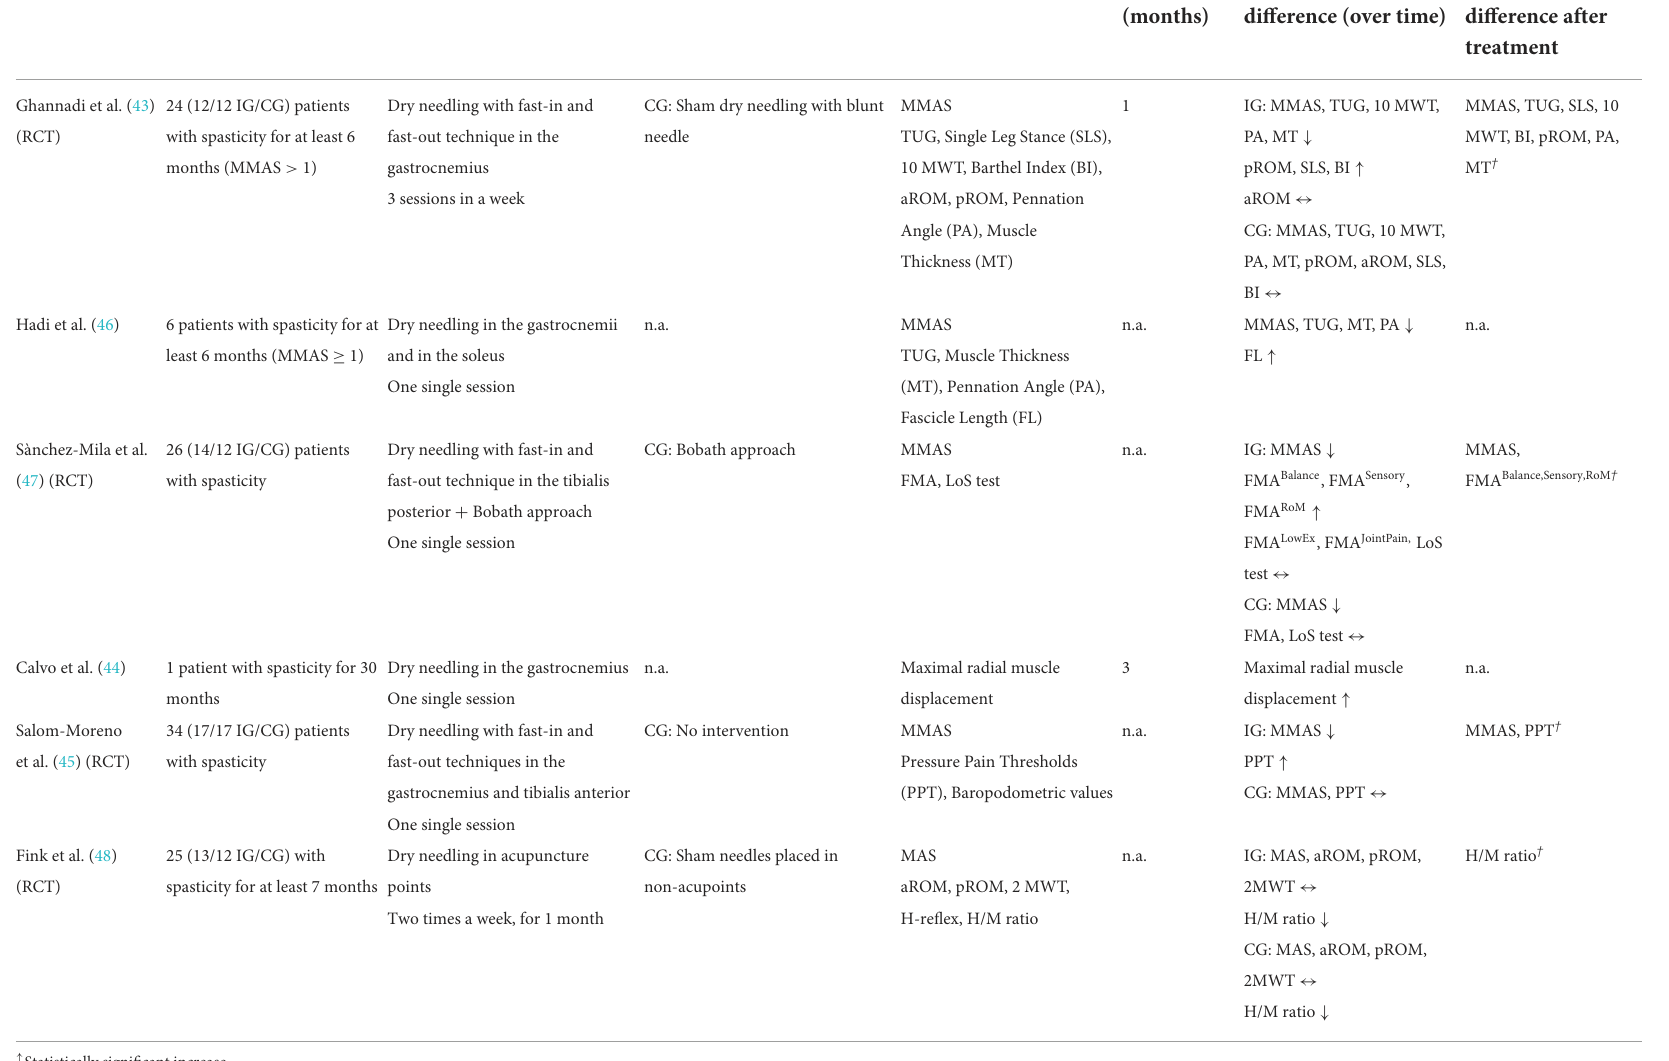
TABLE 4 Characteristics of studies using dry needling for the treatment of triceps spasticity after